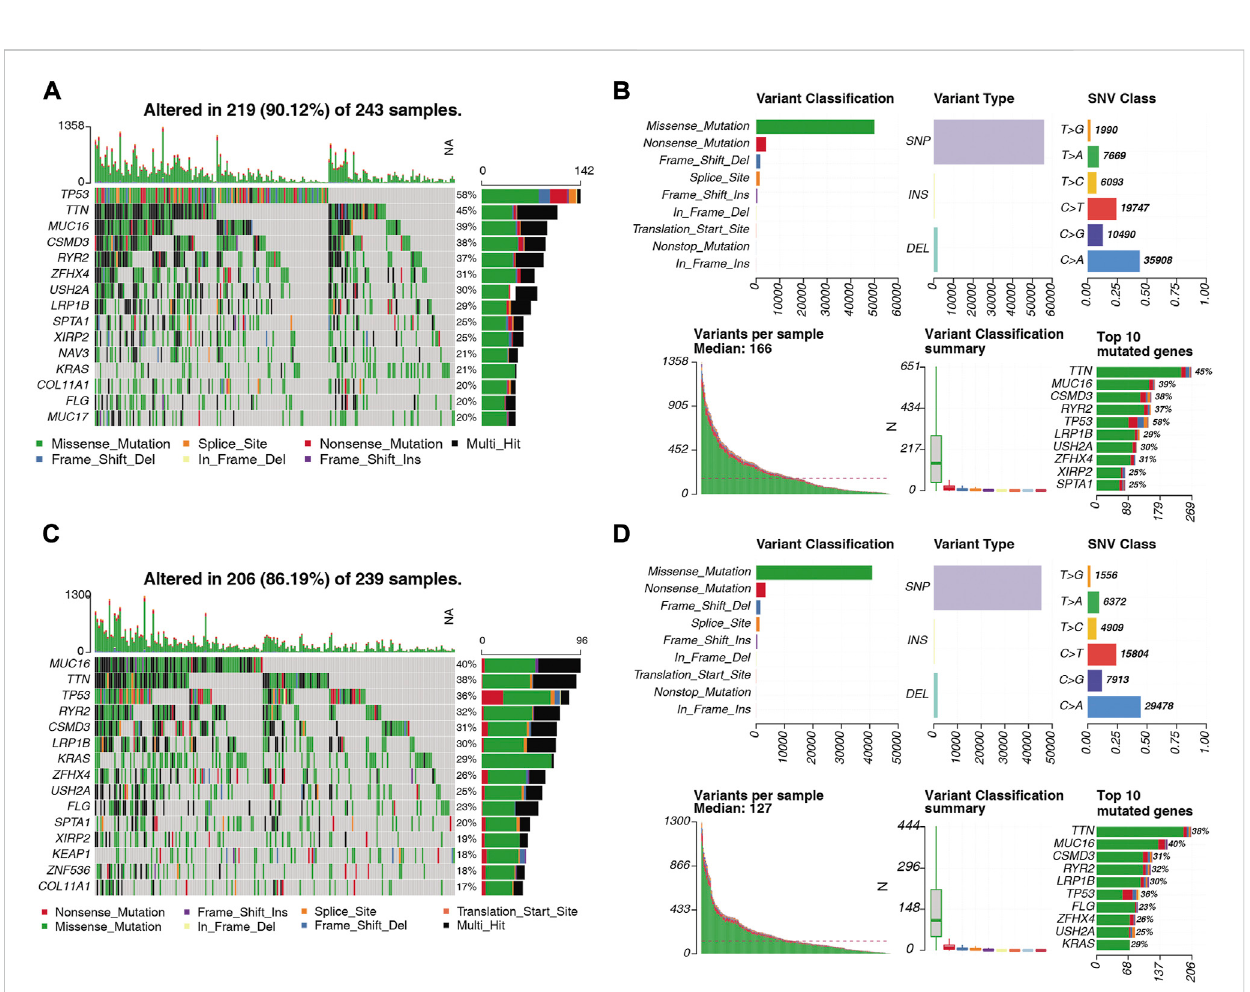
FIGURE 12 Distribution of somatically mutated genes and SNV types in LUAD samples in the (A) high-risk and (C) low-risk groups. (B) Variant classi fi cation of somatic cells in LUAD samples in the high-risk and (D) low-risk groups. Classi fi cation, variant type, SNV class, variants per sample, variant classi fi cation summary